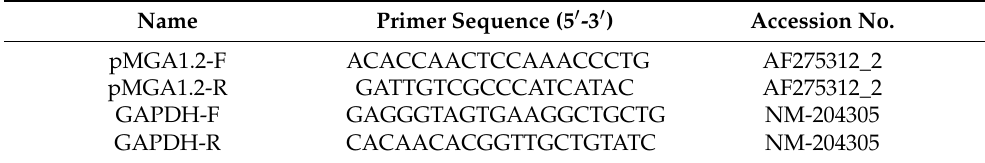
Table 1. Primers for quantitative